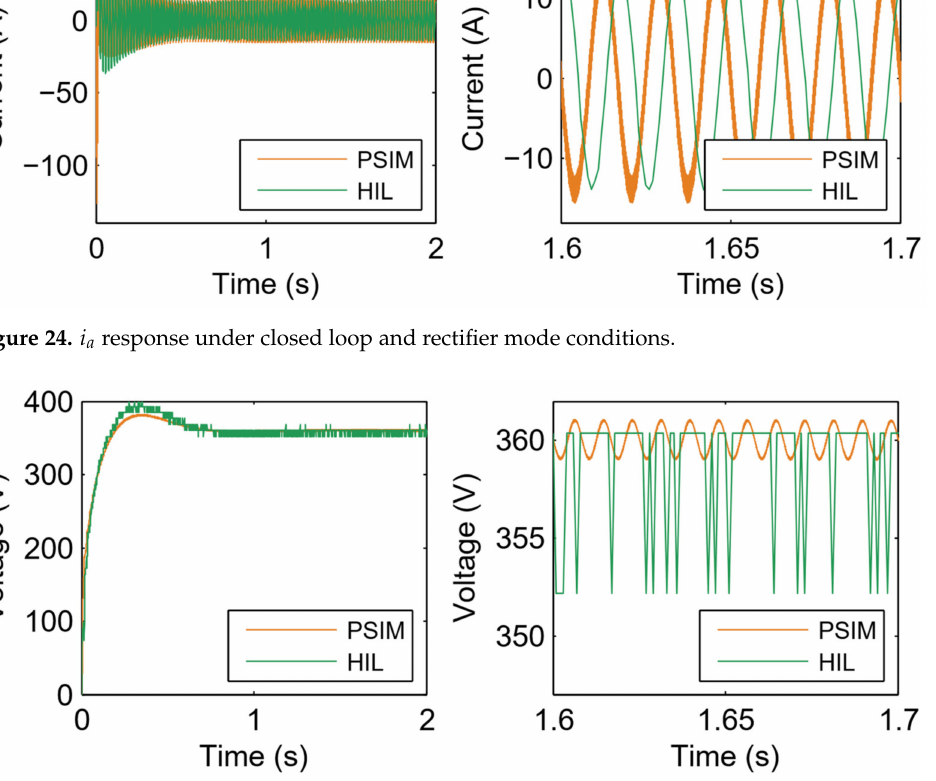
Figure 25. v dc response under closed loop and rectifier mode